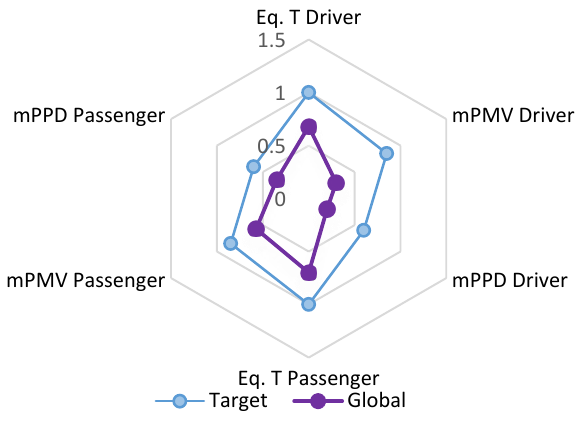
Figure 11. GTCI using modified Fanger’s model.